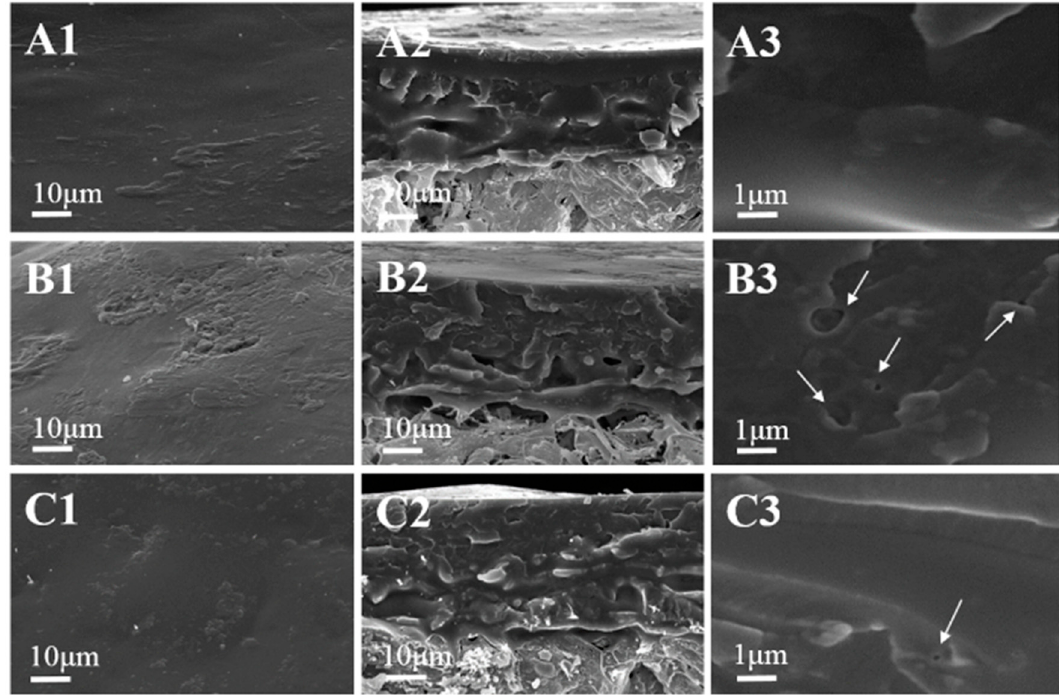
Figure 5. SEM images of FPU, CPU and FCPU: ( A1 ) surface of FPU at 1000 × magnification; ( A2 ) cross-section of FPU at 1000 × magnification; ( A3 ) cross-section of FPU coating materials at 10,000 × magnification; ( B1 ) surface of CPU at 1000 × magnification; ( B2 ) cross-section of CPU at 1000 × magnification; ( B3 ) cross-section of CPU coating materials at 10,000 × magnification; ( C1 ) surface of FCPU at 1000 × magnification; ( C2 ) cross-section of FCPU at 1000 × magnification; and ( C3 ) cross-section of FCPU coating materials at 10,000 × magnification.